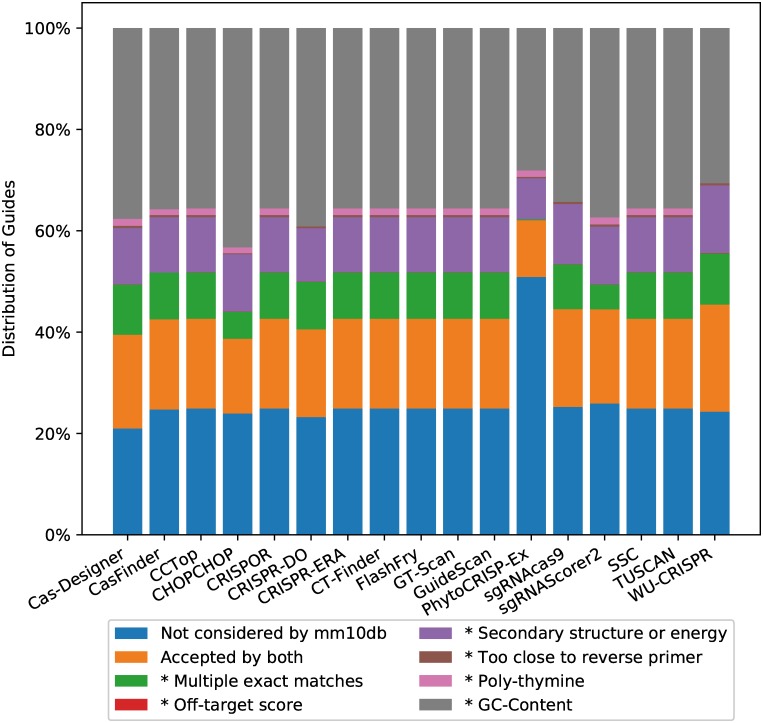
Reasons for rejection.This plot shows, for each tool, the proportion of accepted guides that have been rejected by mm10db, and the reason for doing so. An asterisk (*) indicates the category relates to a rule implemented in mm10db for rejecting guides. mm10db is used as a reference point because it provides a reason for any guide it rejects.